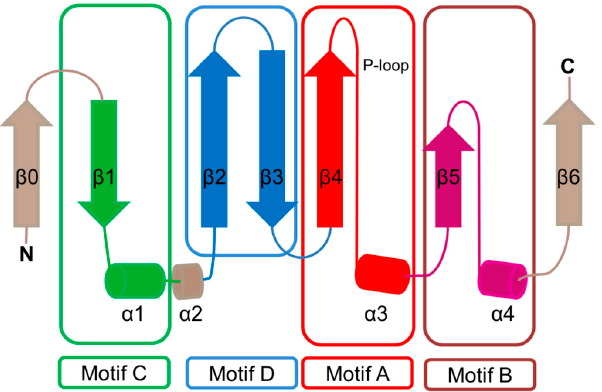
Figure 1. Topology of the general control non-repressible 5 (GCN5)-related N -acetyltransferase (GNAT) enzymes. The secondary structure elements encompassing the conserved sequence motifs C ( β 1– α 1), D ( β 2– β 3), A ( β 4– α 3) and B ( β 5– α 4) are colored green, blue, red and magenta, respectively. The location